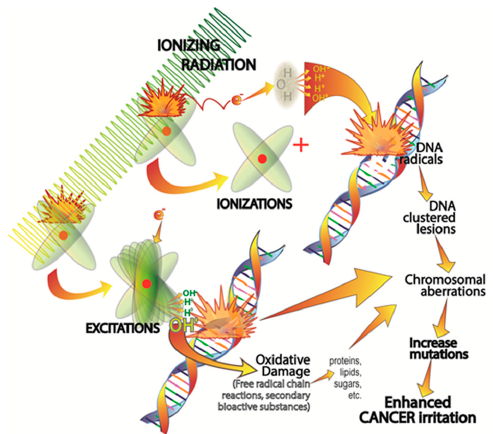
Figure 1. Chemical processes involved in ionizing radiation-mediated cellular injury as they relate